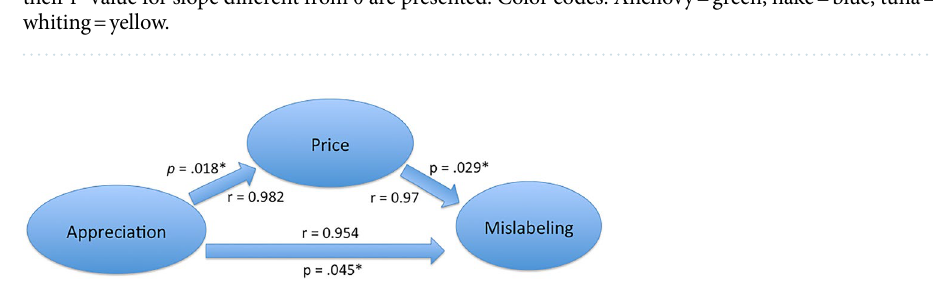
Figure 3. Model of price as a mediator between consumer’s appreciation price and mislabeling. Arrows represent relationships between variables. Pearson’s r coefficients and their p-values are given (* for p <